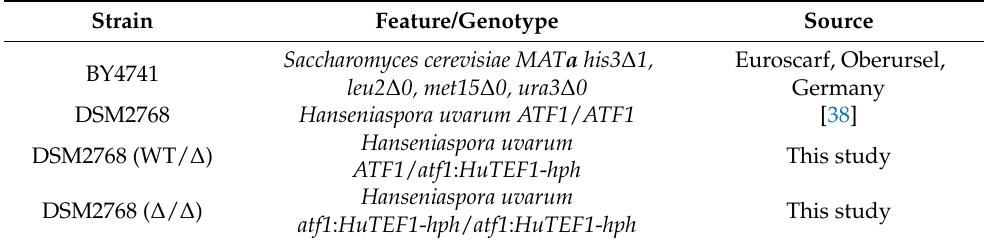
Table 1. Strains used and generated in this